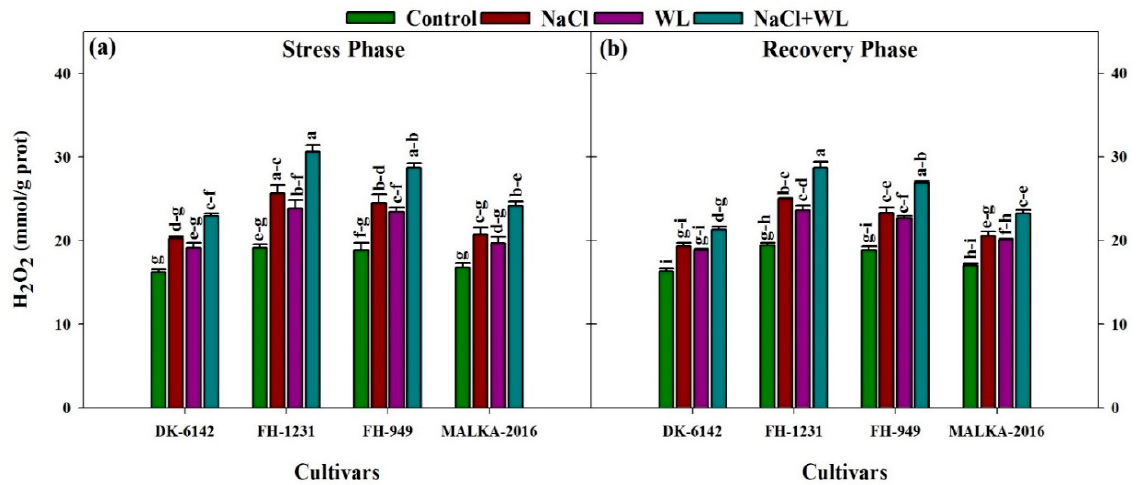
Figure 6. Individual and interactive effects of salinity and waterlogging on the H 2 O 2 concentrations of four maize cultivars during the stress (22 DAS) and recovery (30 DAS) phases. Left and right sides of the figure are representing stress phase and recovery phase respectively. Error bars denote the standard error of three replications. Bars with same letter do not differ significantly at p ≤ 0.05.